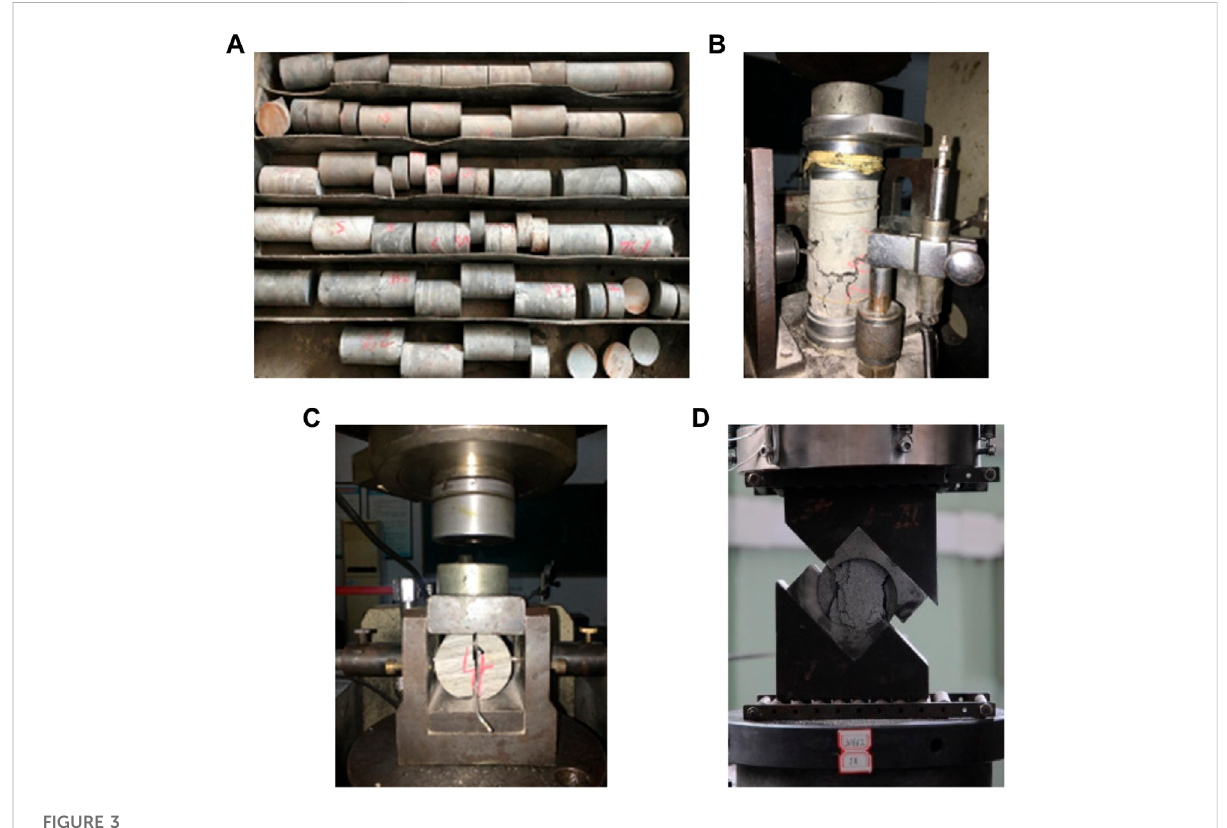
FIGURE 3 Test process of rock